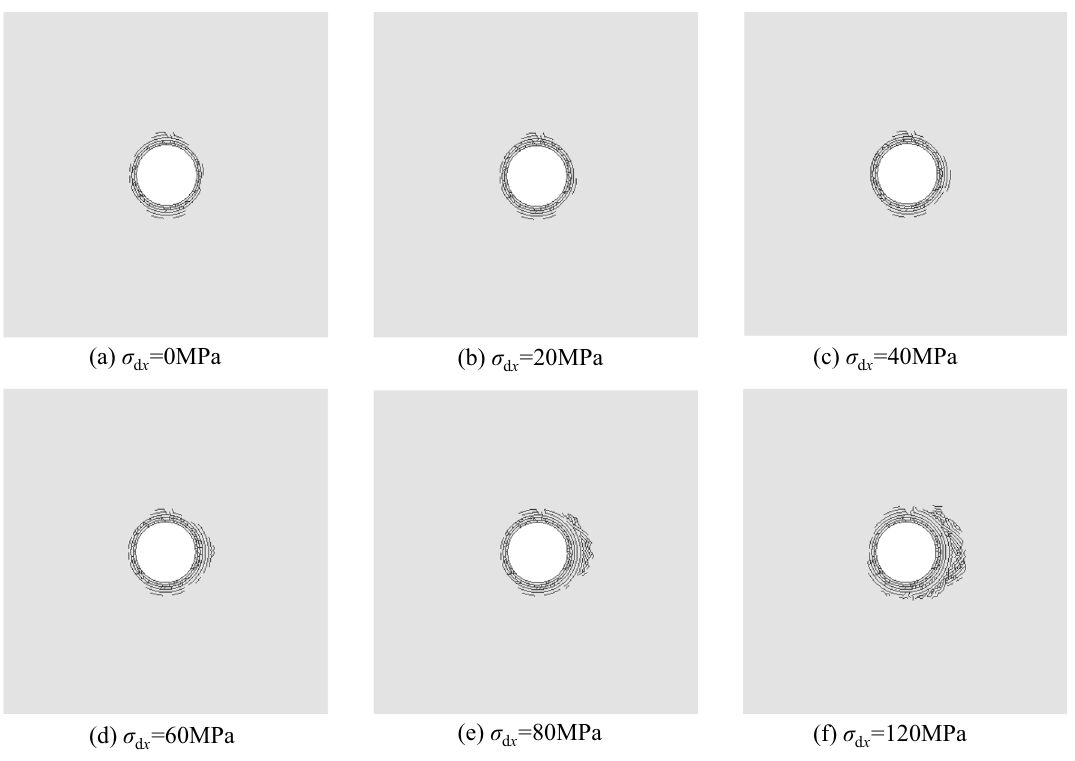
Fig. 13 Final failure modes of circular cavern subjected to various stress-wave amplitudes. Note : σ bances is generated from right